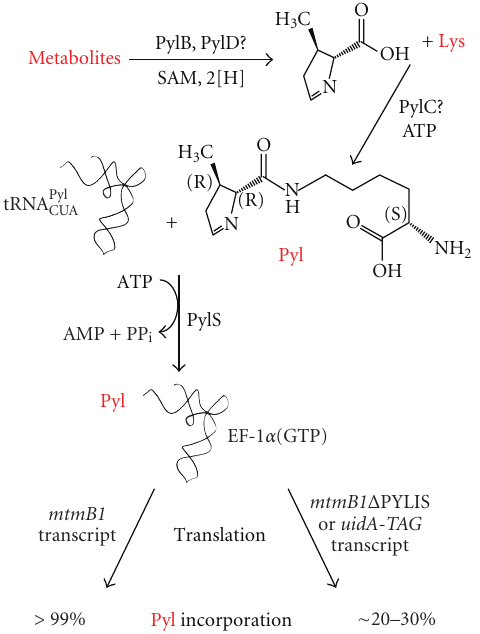
Figure 4: Schematic representation of pyrrolysine incorporation into protein. The pylB , pylC , and pylD genes have been shown to enable pyrrolysine biosynthesis in E. coli , but their exact roles are unknown. A conceptual and speculative scheme is shown which is keeping with the activities of proteins in their respective proteins families. Lysine is likely to form the acyl of pyrrolysine, but may also be coupled to an early precursor which subsequently cyclizes after amide bond formation. Pyrrolysine is given entrance to the genetic code by PylS in Archaea, the equivalent in Bacteria are the products of the split gene pylSc and pylSn . The direct formation of pyl-tRNA Pyl is likely followed by binding to the elongation factor used by the canonical amino acids, that is, EF-1 α in Archaea. The common bacterial elongation factor EF-Tu can bind charged tRNA Pyl both in vivo and in vitro. The recognition of pyl-tRNA Pyl by non-specialized elongation factors underlies the relatively high level of UAG translation in a reporter gene such as uidA with an introduced amber codon in organisms having tRNA Pyl , PylS, and pyrrolysine or an analog to charge tRNA Pyl . The PYLIS is not essential for this level of translation, as shown by replacement of PYLIS in mtmB1 , but may enhance UAG translation to some extent. This e ff ect is unlikely to require the structure formed by PYLIS. See text for further